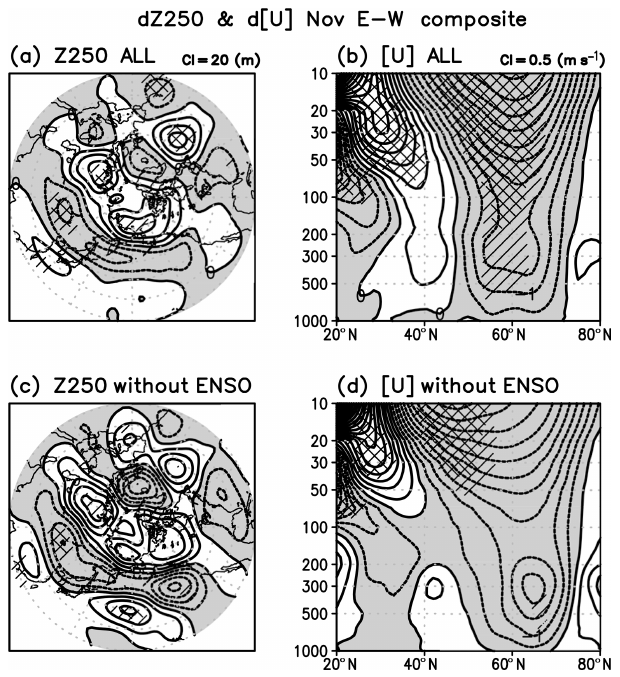
Figure 8. Composite difference of Z250 wavenumbers 1 and 2 in November between EQBO and WQBO winters. (a) Z250 wave- 1 difference (shade) and climatological wavenumber 1 (contour). Contour interval is 25m. (b) Same as panel (a) but for wavenumber 2. (c) Same as panel (a) but without ENSO winters. (d) Same as panel (c) but for wavenumber